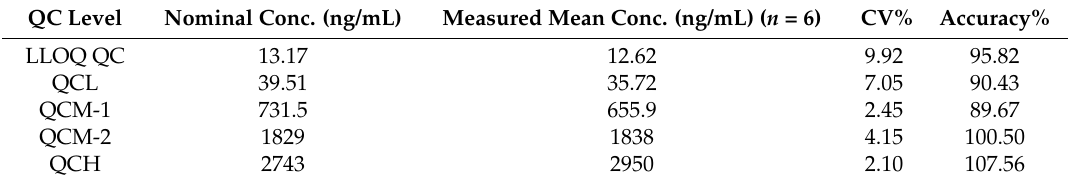
Table 3. Reproducibility of the method for determination of folic acid in human plasma.